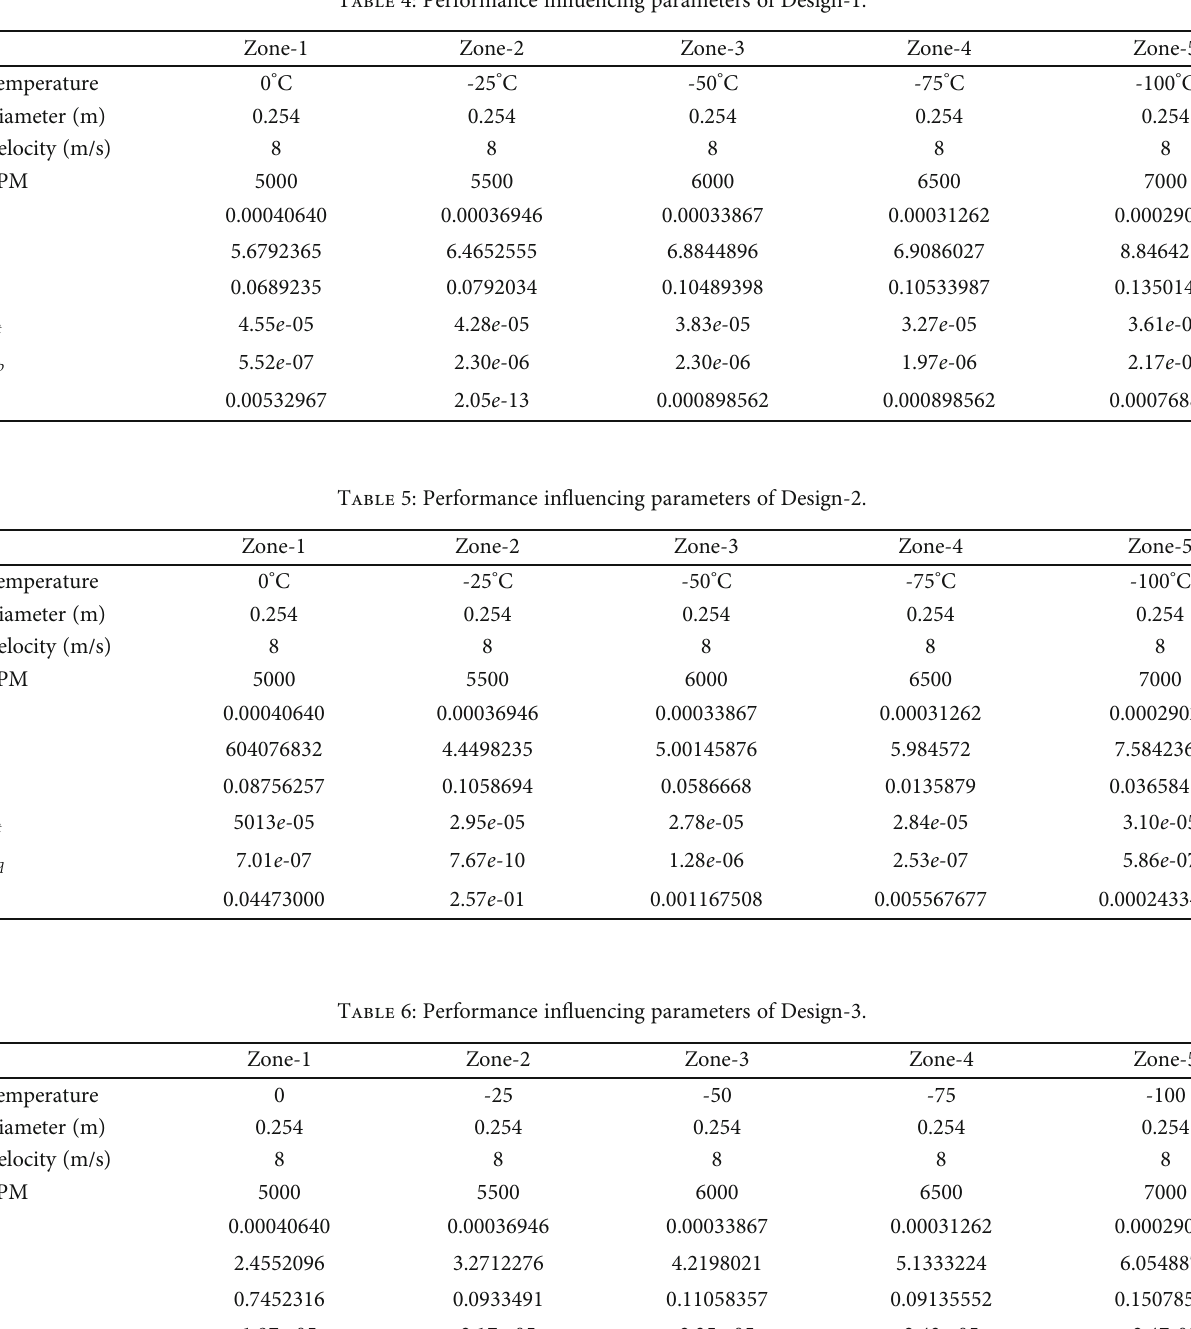
Table 4: Performance in fl uencing parameters of Design-1.